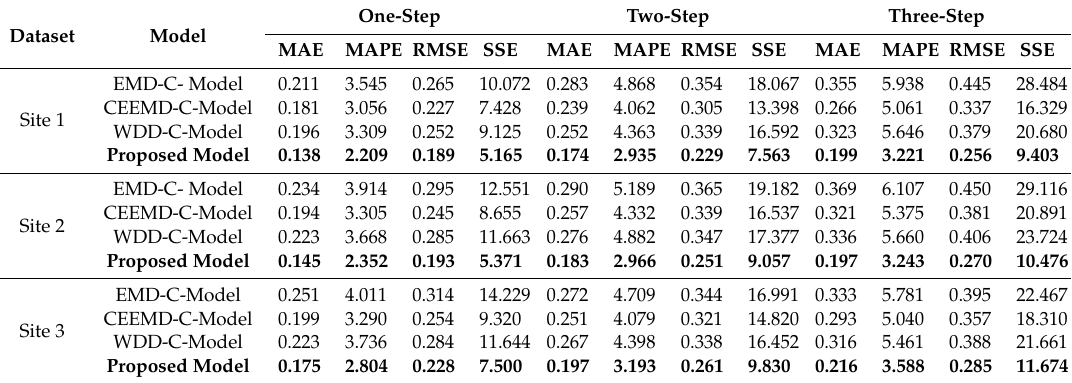
Table 5. Comparison of the evaluation metrics for the proposed strategy with models using di ff erent data pretreatment technologies.